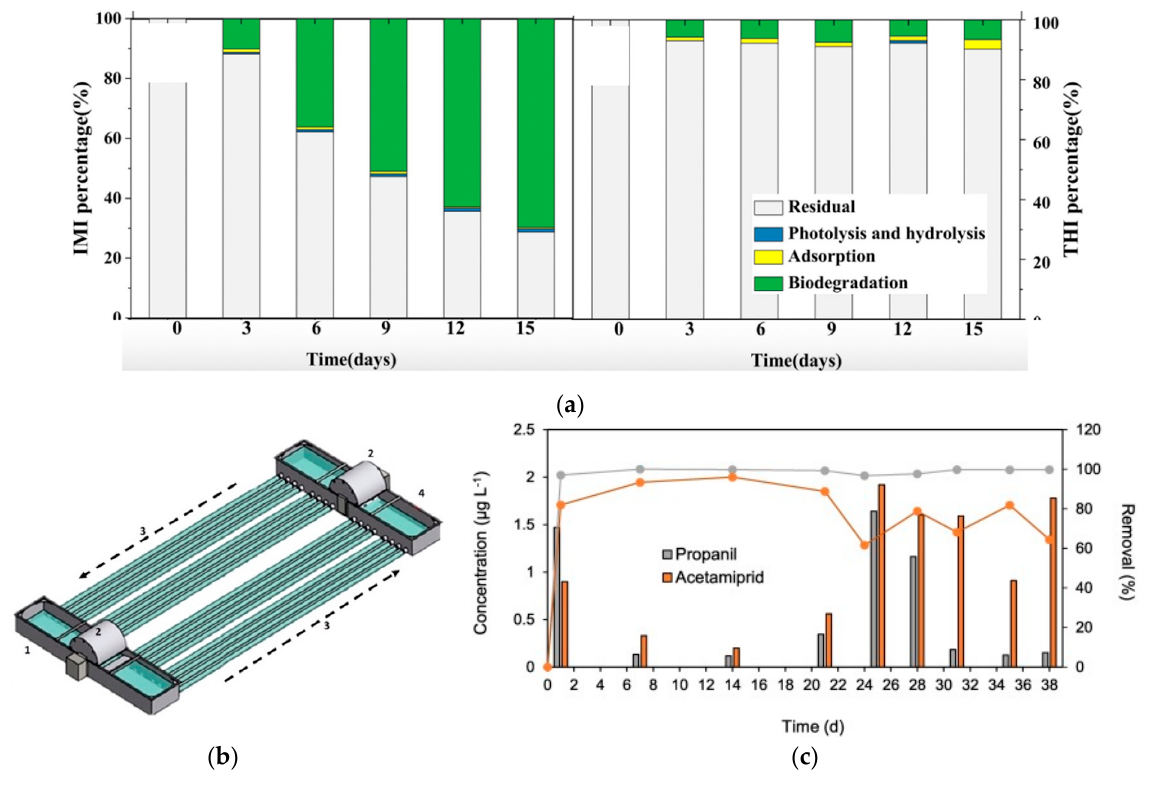
Figure 4. ( a ) The mechanisms involved in the removal of imidacloprid and thiacloprid [129]. ( b ) Schematic diagram of pilot scale semi-closed PBR used for the treatment of agricultural run-off [131]. ( c ) Concentration and removal efficiency of acetamiprid and propanil in the pilot PBR effluent as a function of operation duration [132]. (Reprinted with permission.)